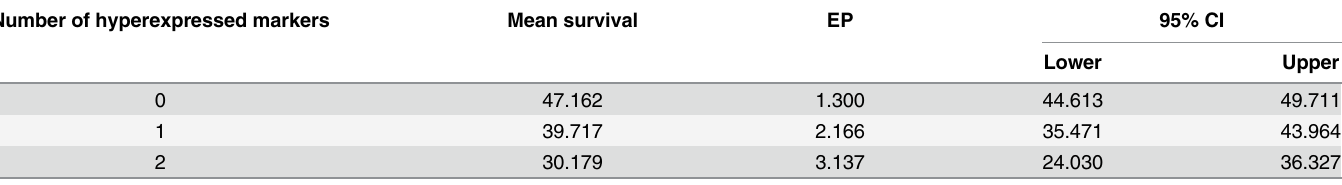
Table 6. Analysis of GS in relation to scoring based on hyperexpression of ITGAV and ITGA6. Number of hyperexpressed markers